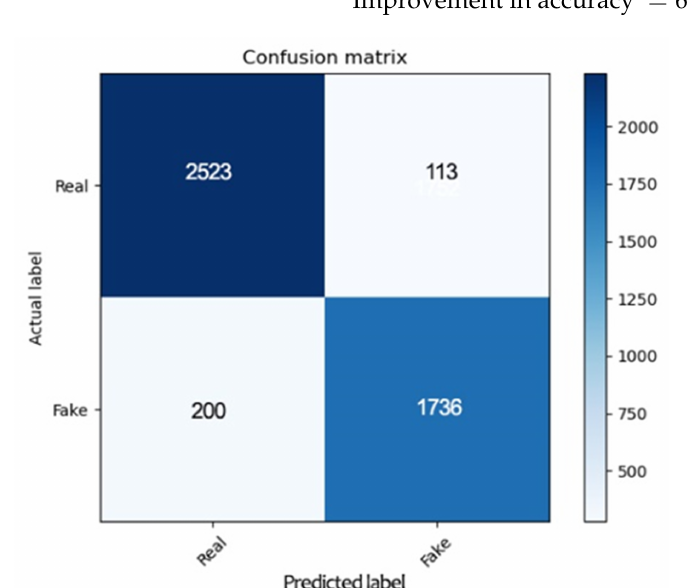
Figure 10. Confusion matrix for SVM.